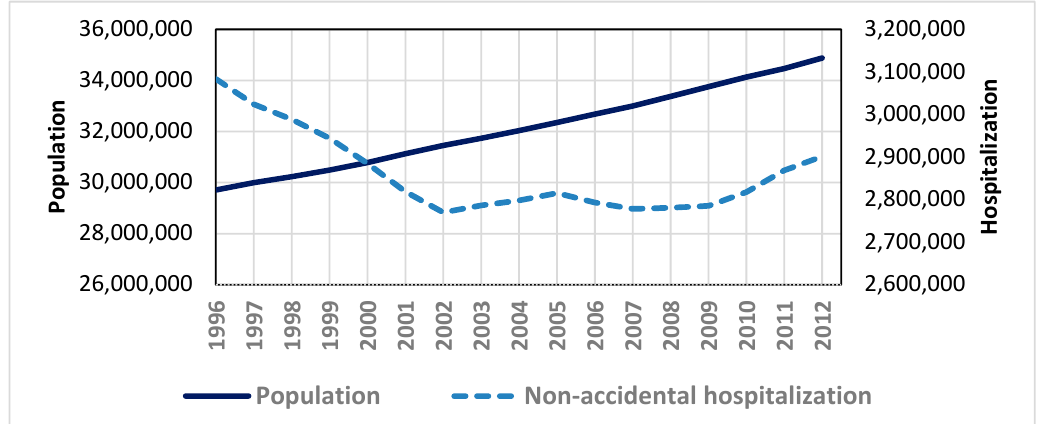
Figure 2. Trends in total population and non-accidental hospitalization counts (in persons) between 1996 and 2012, Canada: solid line for population using left y-axis; dashed line for hospitalizations using right y-axis.